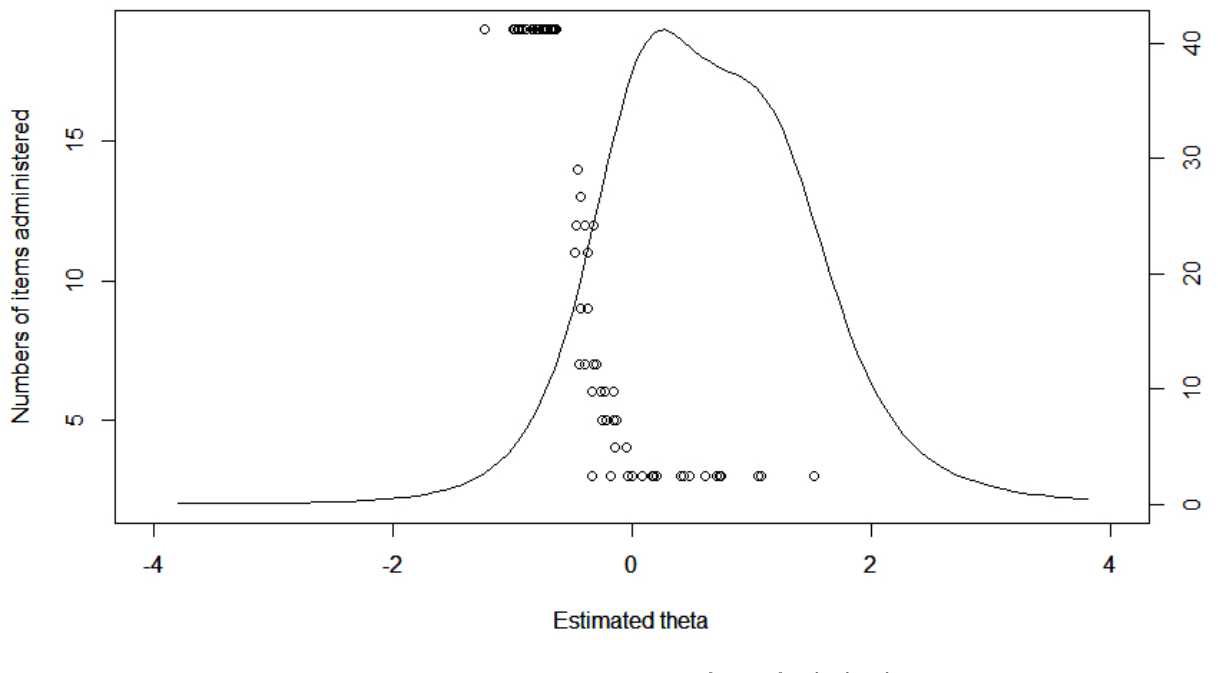
Figure 2. Relationship between level of theta and the number of administered items under stop rule 1. The curve represents test information as a function of